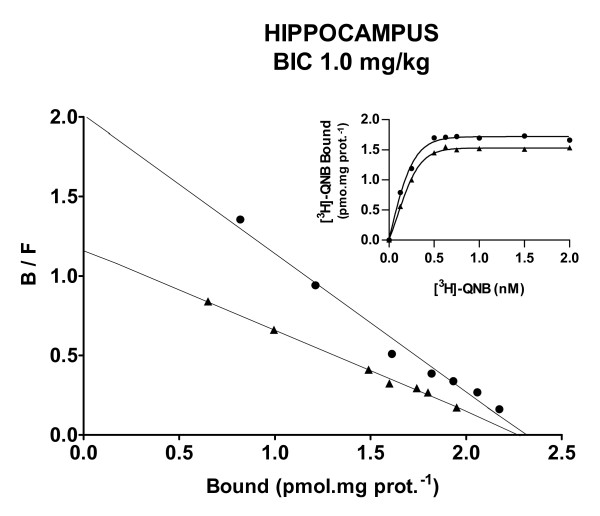
Scatchard plots for [3H]-QNB binding to rat hippocampal membranes at equilibrium after administration of a subconvulsant BIC dose (1.0 mg/kg). Results are from a single experiment representative of a set of three, each performed in duplicate. Inset, saturation curves. (●) Control; (▲) BIC subconvulsive.